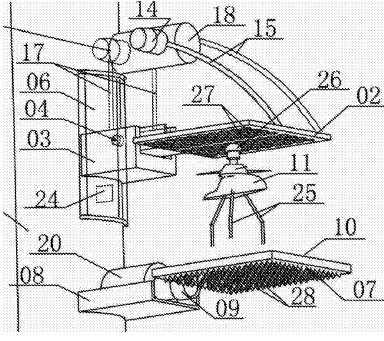
Figure 7. UAV charging system [40]. 02, upper electrode; 10, landing pad; 11, UAV; 25, UAV legs (lower electrodes); 26, UAV upper spherical